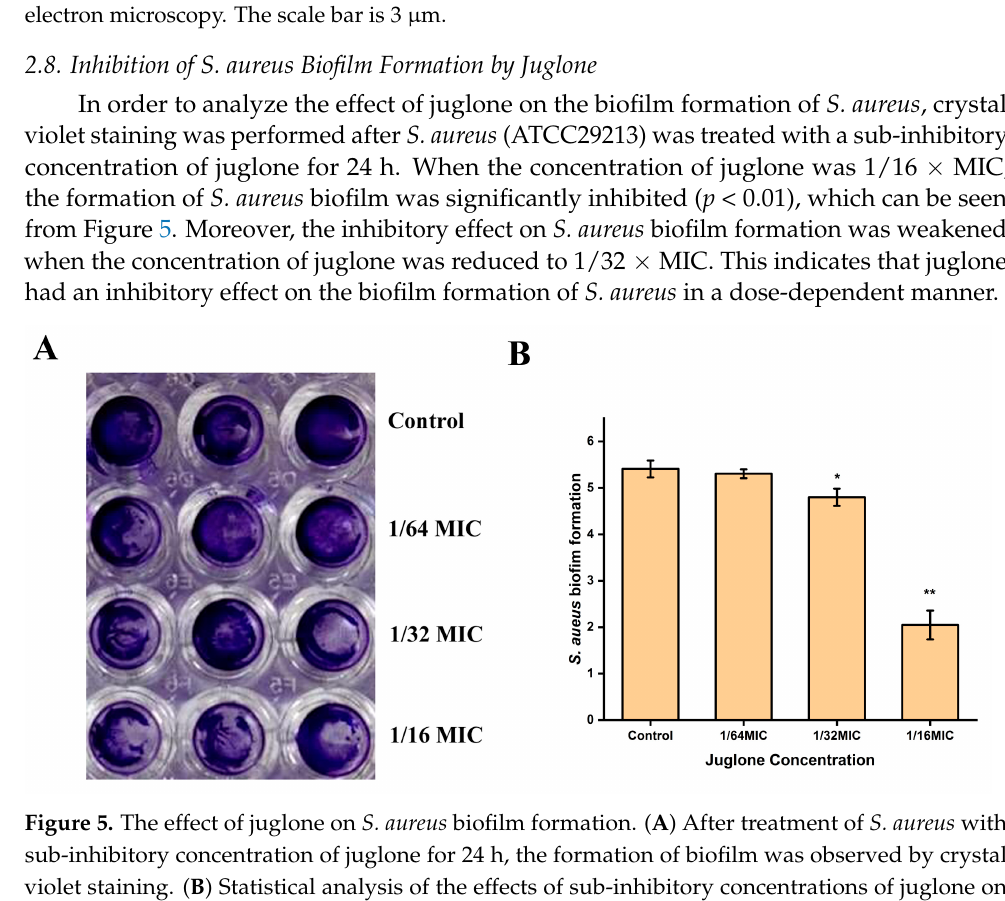
Figure 4. Effect of juglone on the cell morphology of S. aureus observed by field emission scanning electron microscopy. The scale bar is 3 μ m.